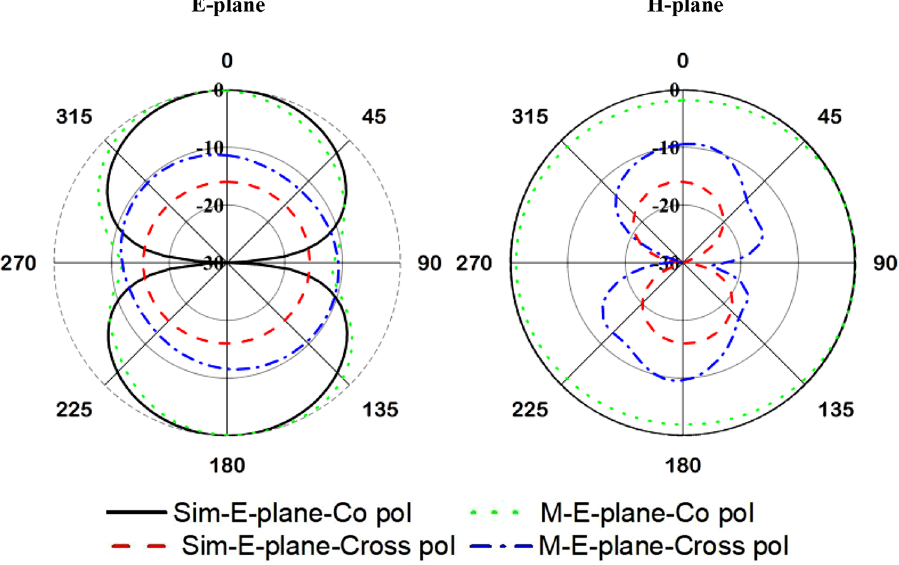
Figure 11. Simulated and measured 2D radiation patterns of the proposed antenna mounted on Cube satellite backplane at 450